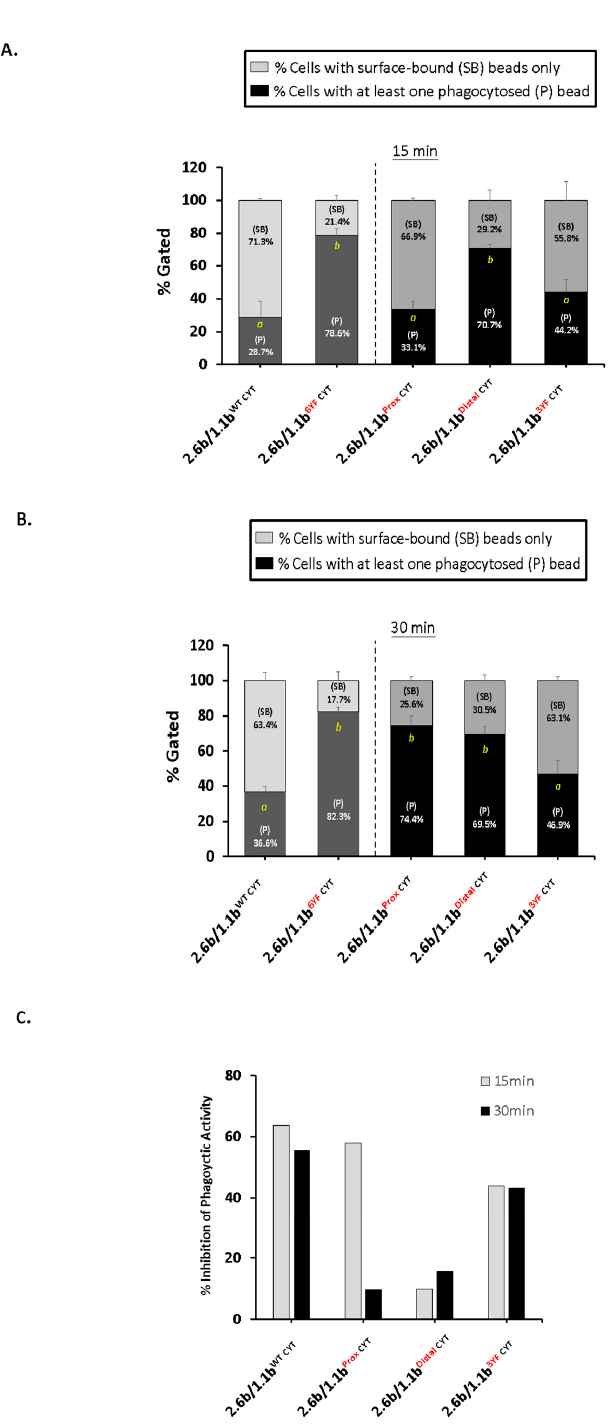
Figure 2. Csk-binding motif (tyrosine 453) and immunoreceptor tyrosine-based inhibitory motifs (ITIMs, tyrosine 477 and 499) in the cytoplasmic region of 1.1b WT CYT are required to sustain the inhibition of 2.6b ITAM CYT -mediated phagocytosis. AD293 cells (2 × 10 5 ) co-expressing 2.6b ITAM CYT and various 1.1b CYT constructs (i.e., 1.1b WT CYT , 1.1b 6YF CYT , 1.1b Prox CYT , 1.1b Distal CYT, and 1.1b 3YF CYT ) were incubated with 4.5 µm yellow-green beads (6 × 10 5 ) opsonized with α -HA and α -FLAG mAbs for 15 min ( A ) and 30 min ( B ) at 37 °C prior to the analysis of samples using the ImageStream X Mark II